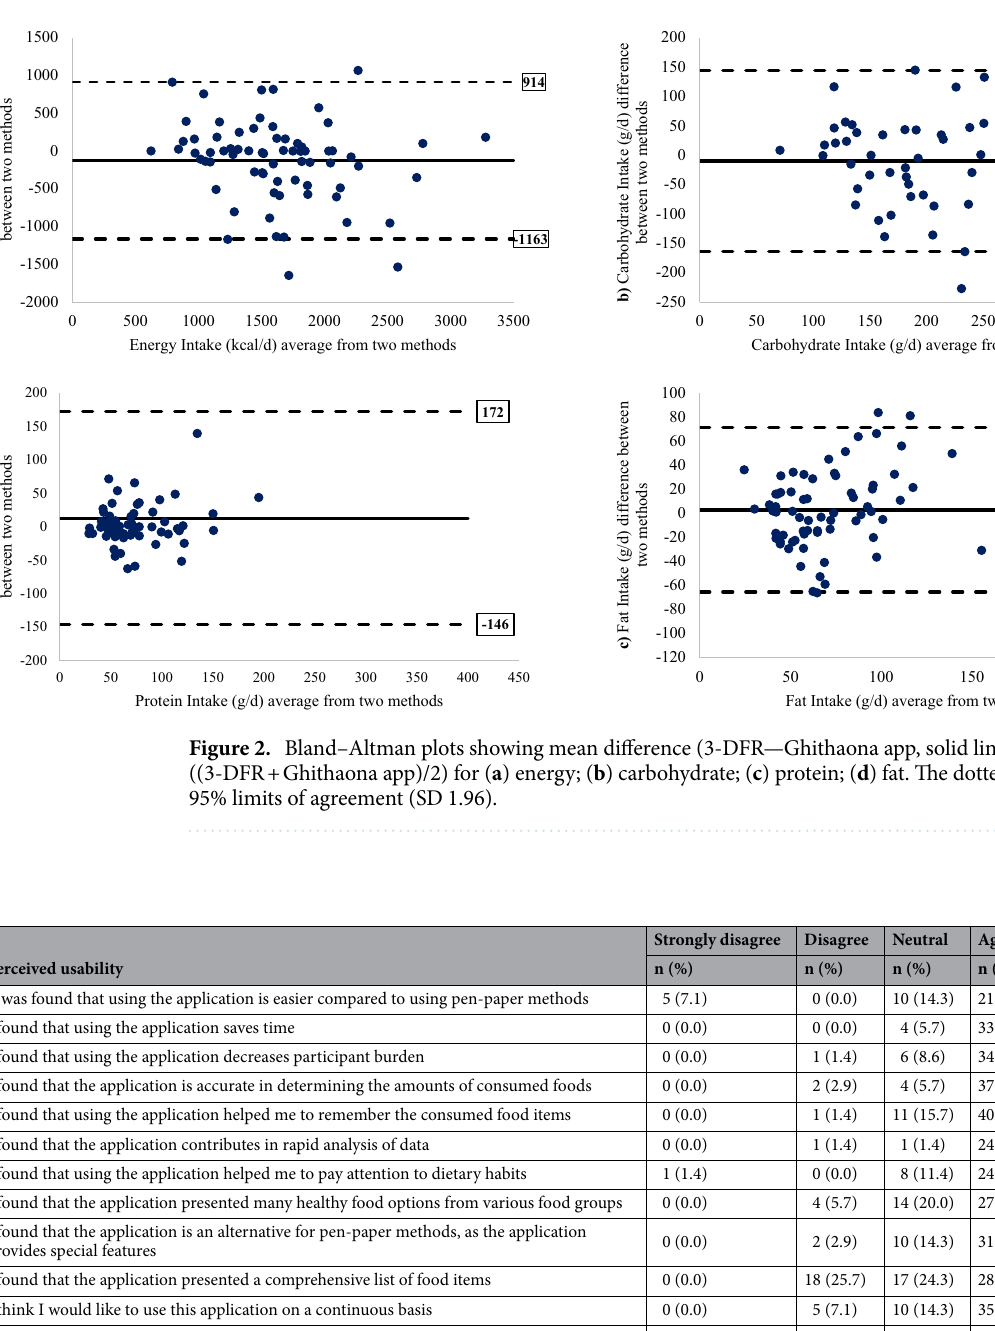
Table 3. Participants’ perceived usability of using the Ghithaona application for dietary assessment (n = 70).